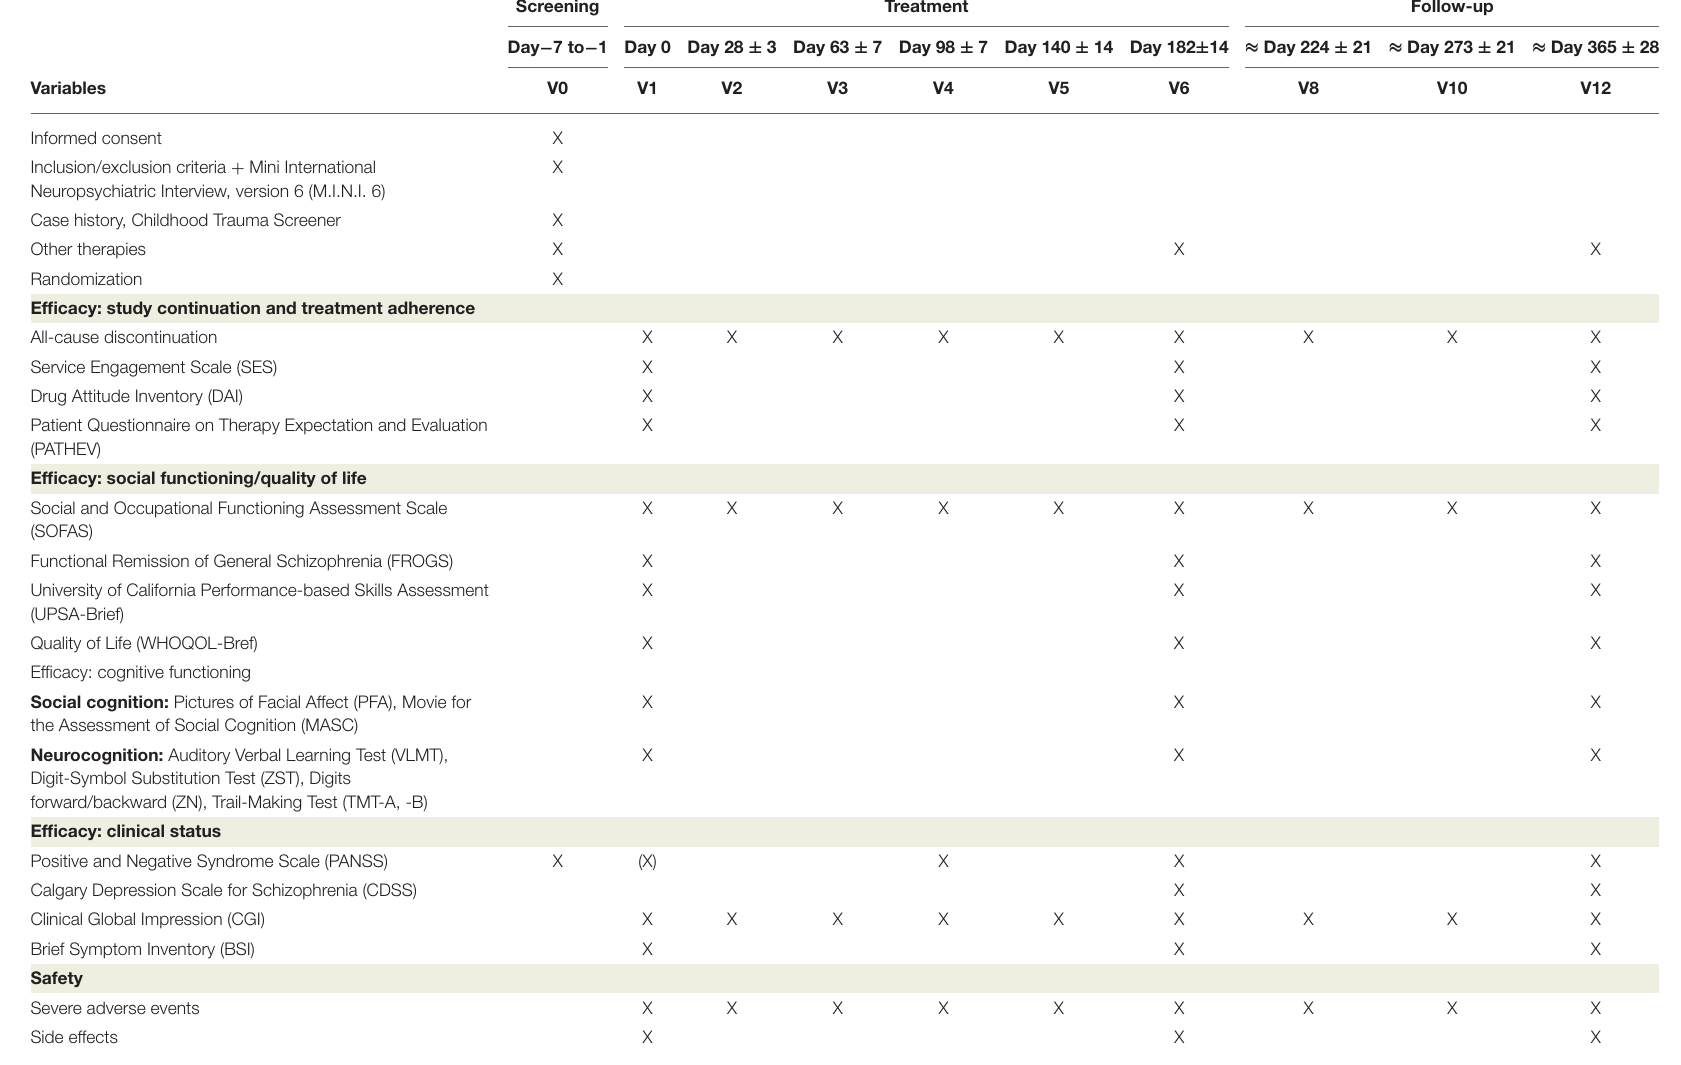
TABLE 2 | Schedule of enrolment, interventions, and assessments. Screening Treatment